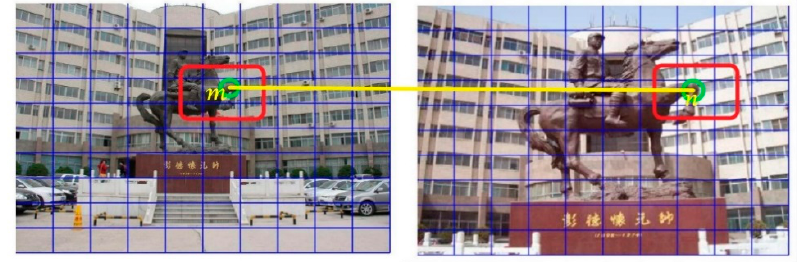
Figure 6. Nine regions around cells ( m , n ) used in score evaluation.